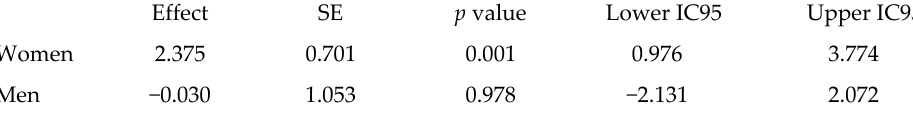
Figure 4. Voxel-based morphometry caudal anterior cingulate cortex (ACC) density as a mediator of the relationship between visceral adiposity index (VAI) and binge eating scale (BES) score, using sex as moderator. The figure shows unstandardized β regression coefficients with standard error (SE) or 95% confidence interval (IC95), with a number of bootstrap samples of 10000. β a : effect of VAI score on caudal ACC; β b : effect of caudal ACC on BES score; β c1: total effect of VAI on BES score; β c2 : direct effect of sex on BES score; β IE : indirect effect of VAI on BES score; IC95: 95% confidence interval; α : percentage of the effect of VAI on BES score that is mediated by voxel-based morphometry caudal ACC density; se: standard error; * p < 0.05. ** p < 0.005.